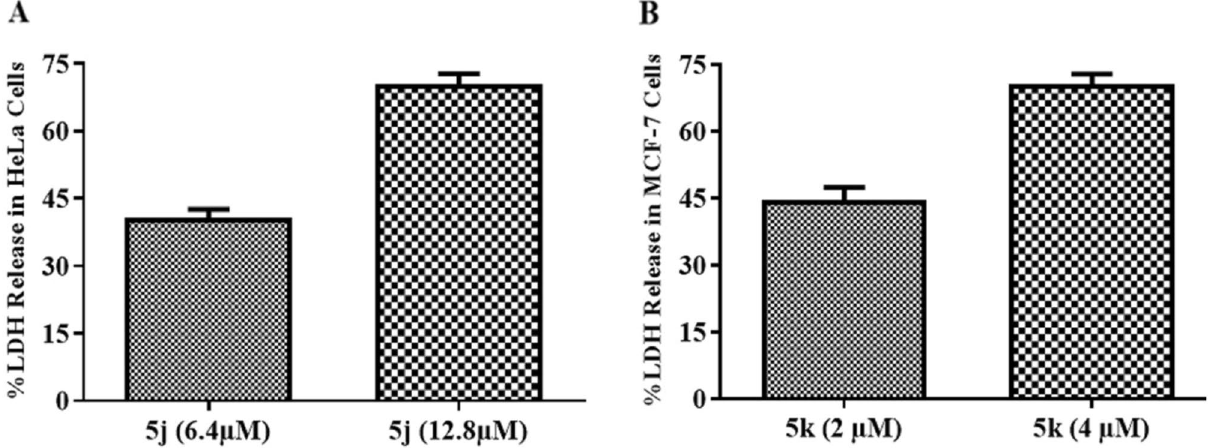
Figure 1. Cytotoxic effect of compounds 5j and 5k observed in ( A ) HeLa and ( B ) MCF-7 cells respectively by estimation of released LDH. Error bars represent standard deviation of three